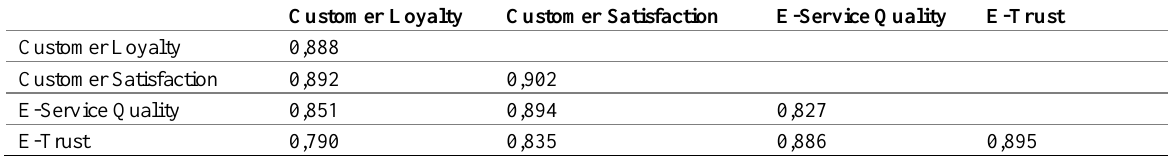
Table 2: Root Average Variance Extracted (√AVE)